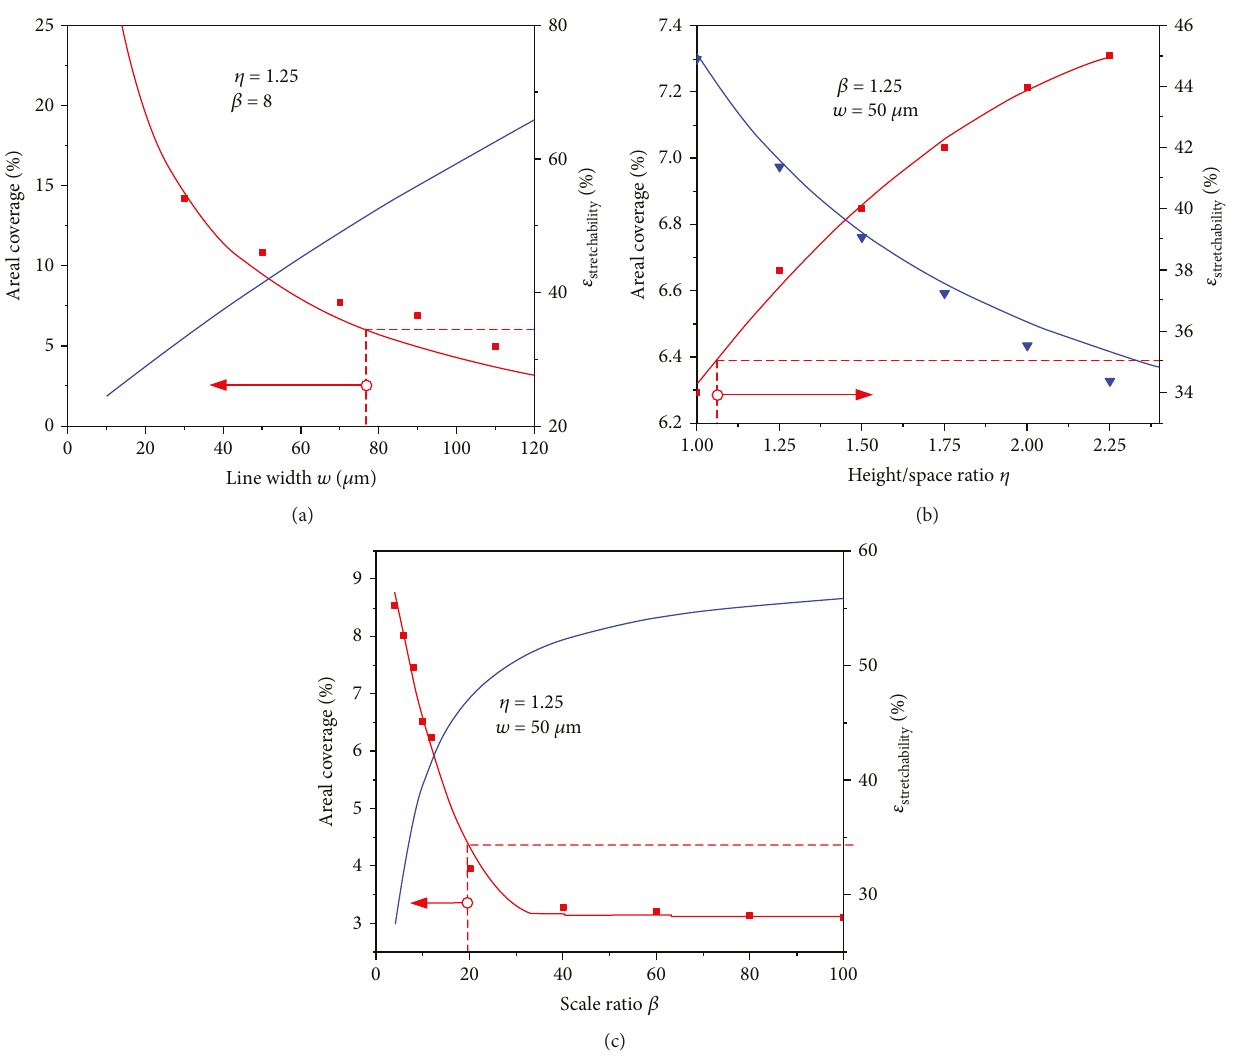
Figure 3: The e ff ects of geometry parameters of the microinterconnect structure on the areal coverage and stretchability. (a) Line width w ; (b) height-space ratio η ; and (c) scale ratio β